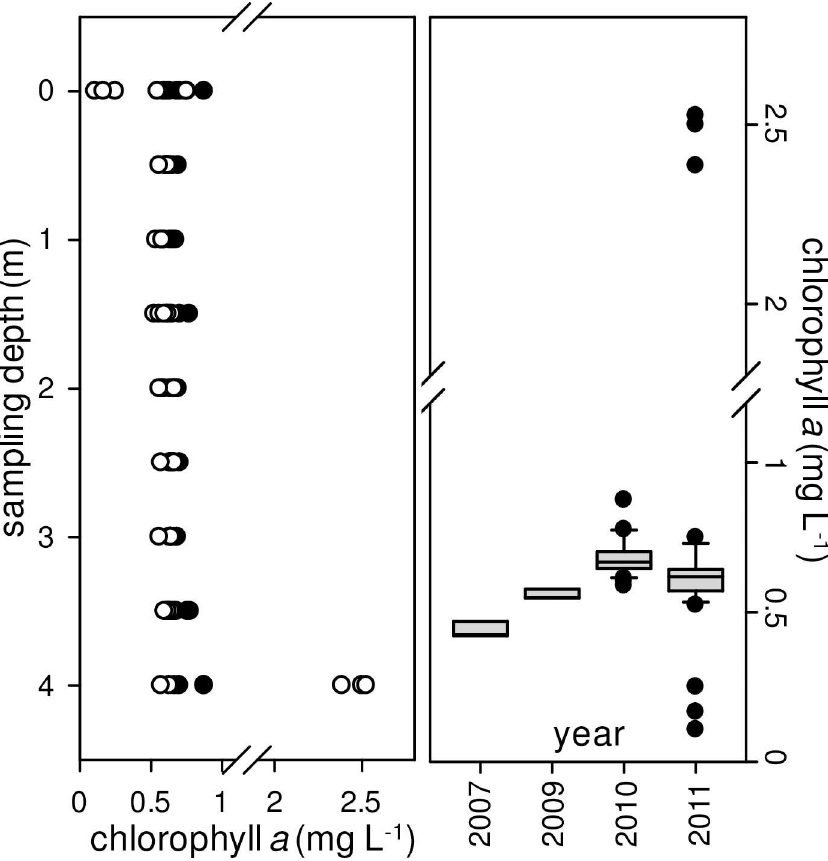
Fig 4. Chlorophyll a dynamics in the Dziani Dzaha during 2010 and 2011surveys. (A) Sum of all chl a measuresdepending on samplingdepth for 2010 (closedcircles, n = 27) and 2011 (open circles, n = 37) surveys. (B) Box-plotindicatingmedian,10th and 90th percentiles (whiskers) and outliers(closed circles) for chl a concentrations includingsinglesamples collectedin 2007 (n = 3) and 2009 (n = 3), and 2010 (n = 33) and 2011 (n = 47)